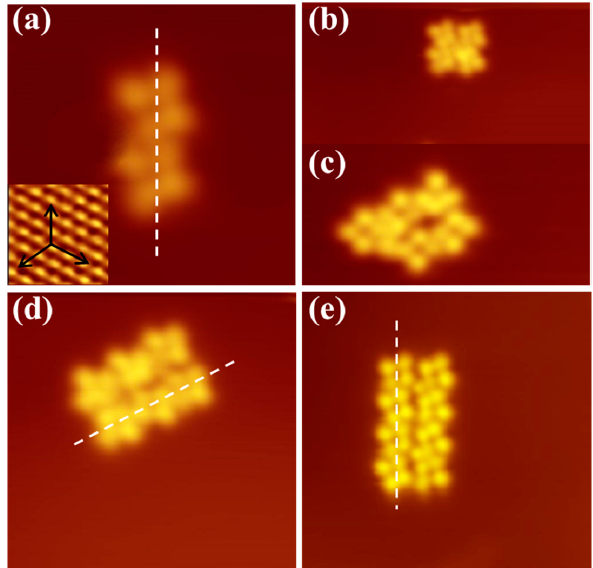
Figure 2. ( a ) A CuPc dimer adsorbed on the Bi(111) surface without any rotation, the arrows and dashed line represent the directions of Bi(111) surface base vectors, 6 × 6 nm, − 1.7 V, 30 pA; ( b , c ) are the STM images of CuPc tetramer and pentamer, respectively; ( d ) STM image of a CuPc hexamer